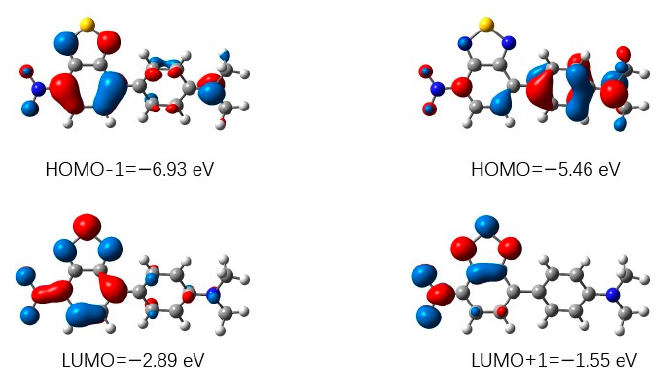
Figure 3. Calculated frontier molecular orbitals of BTN.